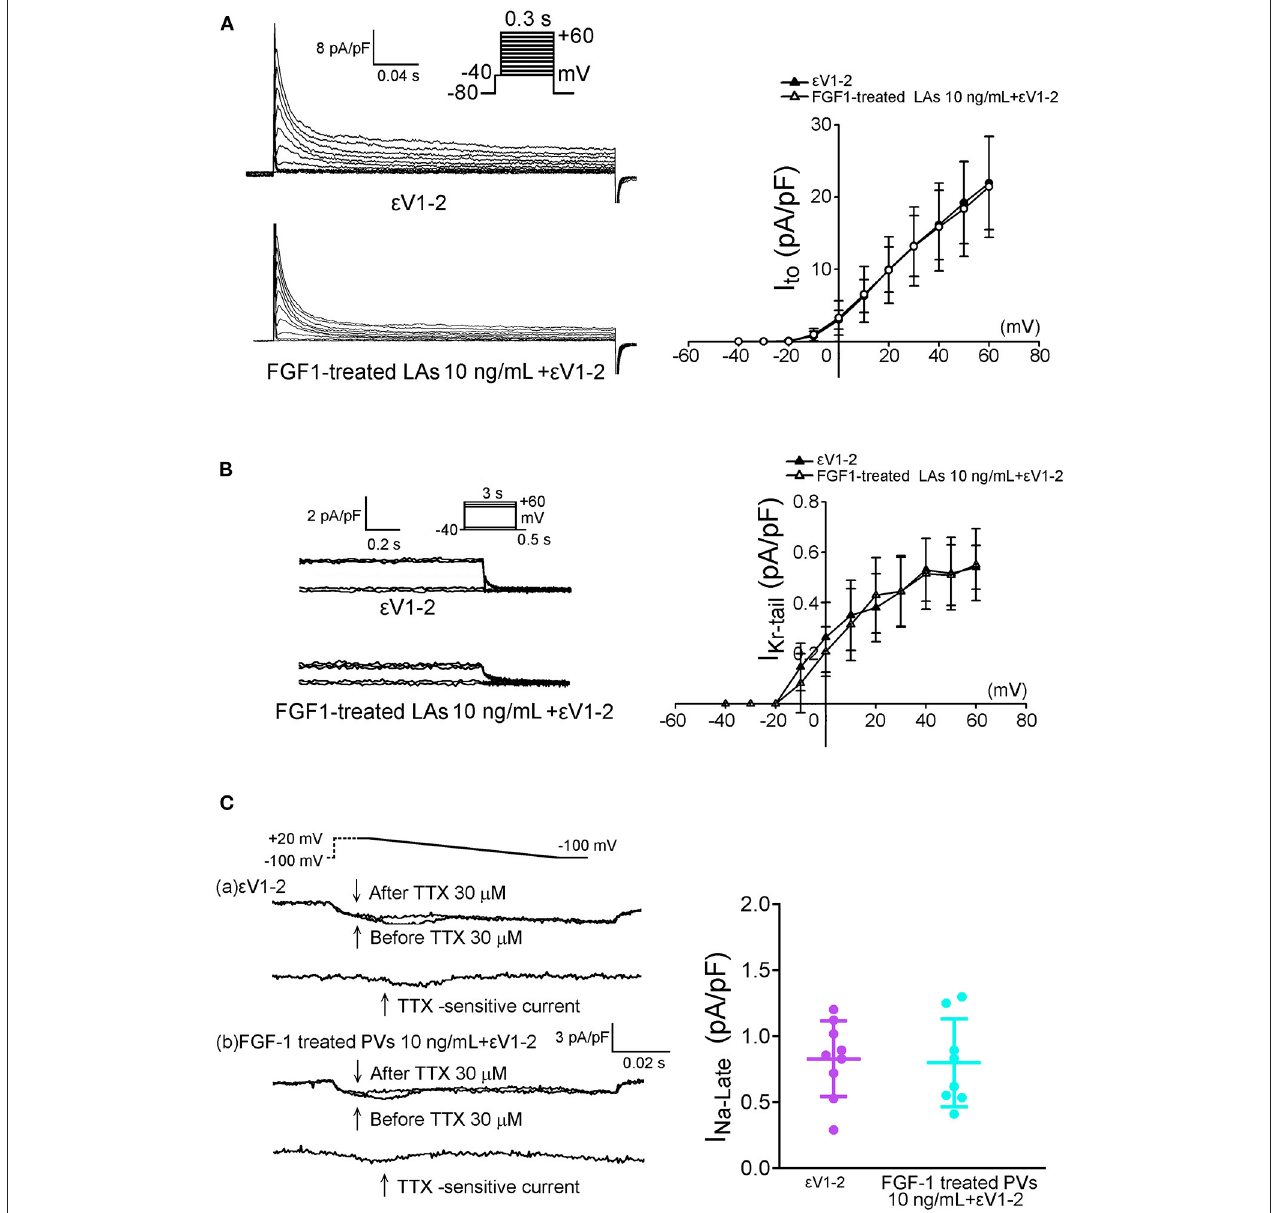
FIGURE 6 | Effect of protein kinase C epsilon inhibitor ( ε V1-2) on transient outward potassium current ( I to ) and rapid delayed rectifier potassium current ( I Kr − tail ) in FGF1-treated left atrial (LA) myocytes, and on late sodium current ( I Na − Late ) in FGF1-treated pulmonary vein (PV) myocytes. (A) Examples of current traces and I–V relationship of I to in FGF1 (10ng/mL)-treated LA myocytes with or without ε V1-2 (200nM) (each N = 7). (B) Examples of current traces and I–V relationship of I Kr − tail in FGF1 (10ng/mL)-treated LA myocytes with ( N = 8) or without ( N = 9) ε V1-2 (200nM). (C) Examples of current traces and average data of I Na − Late in FGF1 (10ng/mL)-treated PV myocytes with ( N = 8) or without ( N = 9) ε V1-2